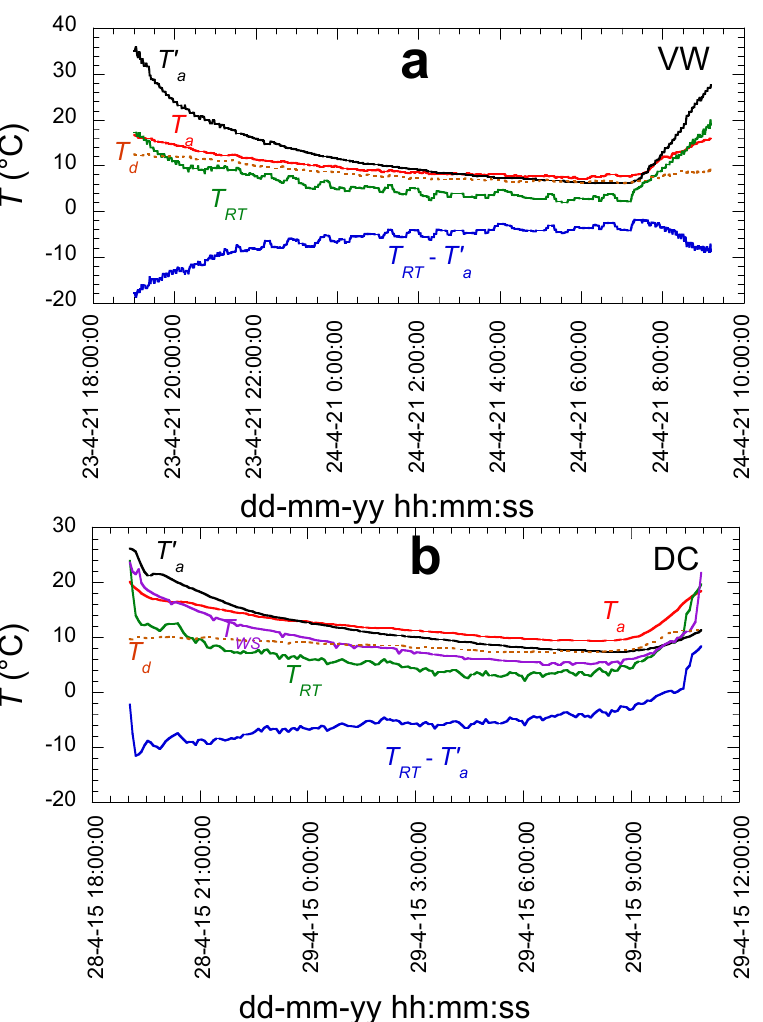
Figure 7. Night temperature evolution of outside air temperature, T a , temperature inside the car T (cid:48) a , dew point temperature T d , rooftop temperature, T RT , windshield temperature, T WS , and difference T RT − T (cid:48) a . ( a ) VW car in Ajaccio (23–24 April 2021, time UT + 2). ( b ) DC car in Valparaiso (28–29 April 2015, time UT − 3).